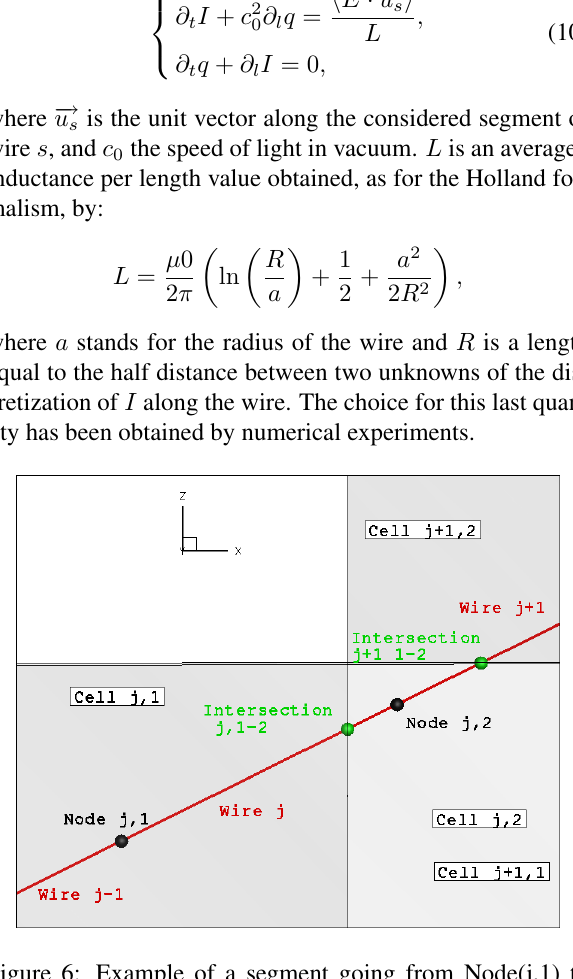
Figure 5: E x component evaluated at the point ( x = 8 m , y = 3 . 25 m , z = 1 m ).